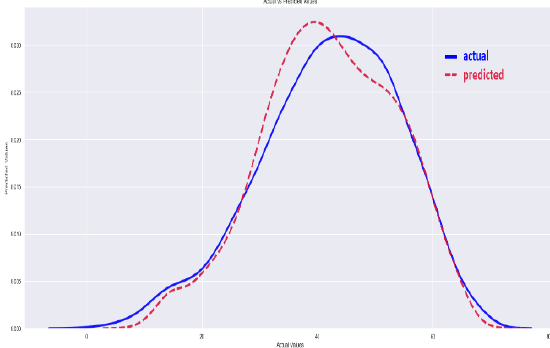
Fig. 5. Actual vs Predicted for Module Temperature using Linear